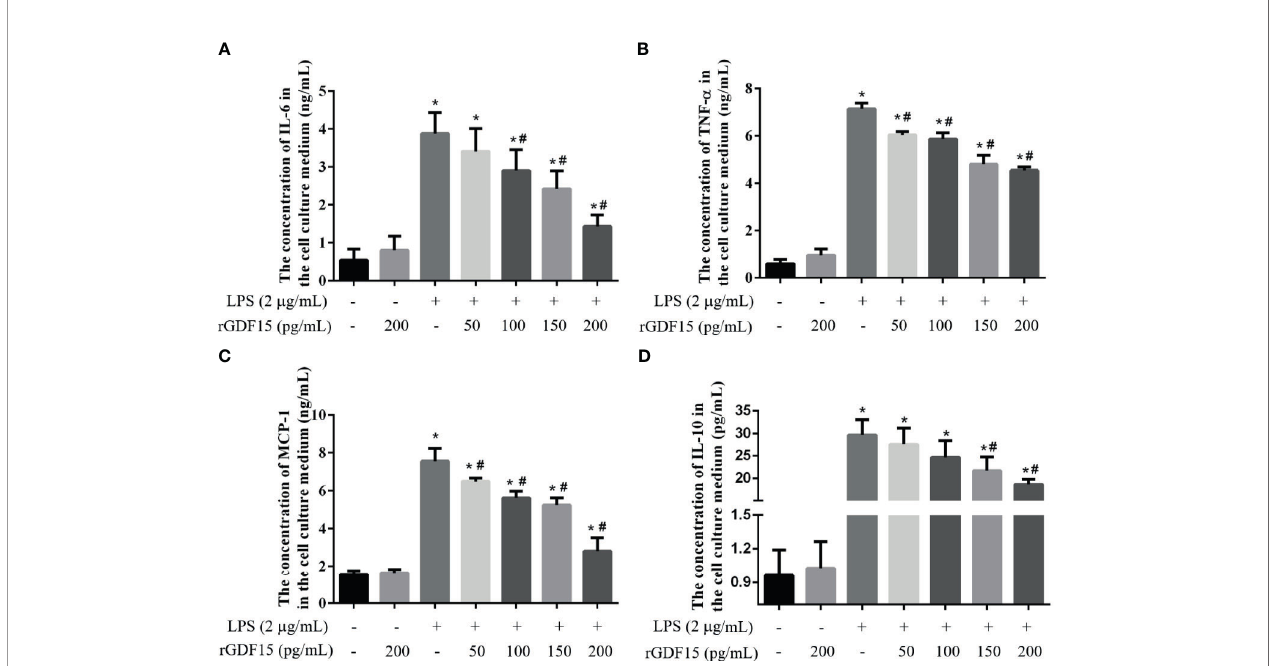
FIGURE 10 | The levels of IL-6 (A) , TNF- a (B) , MCP-1 (C) , and IL-10 (D) were changed after pretreatment with rGDF15 in in fl ammatory state of RAW264.7 cells. These cytokines were measured by fl ow cytometry. * P < 0.05, compare with the blank group; # P < 0.05, compare with the LPS group.